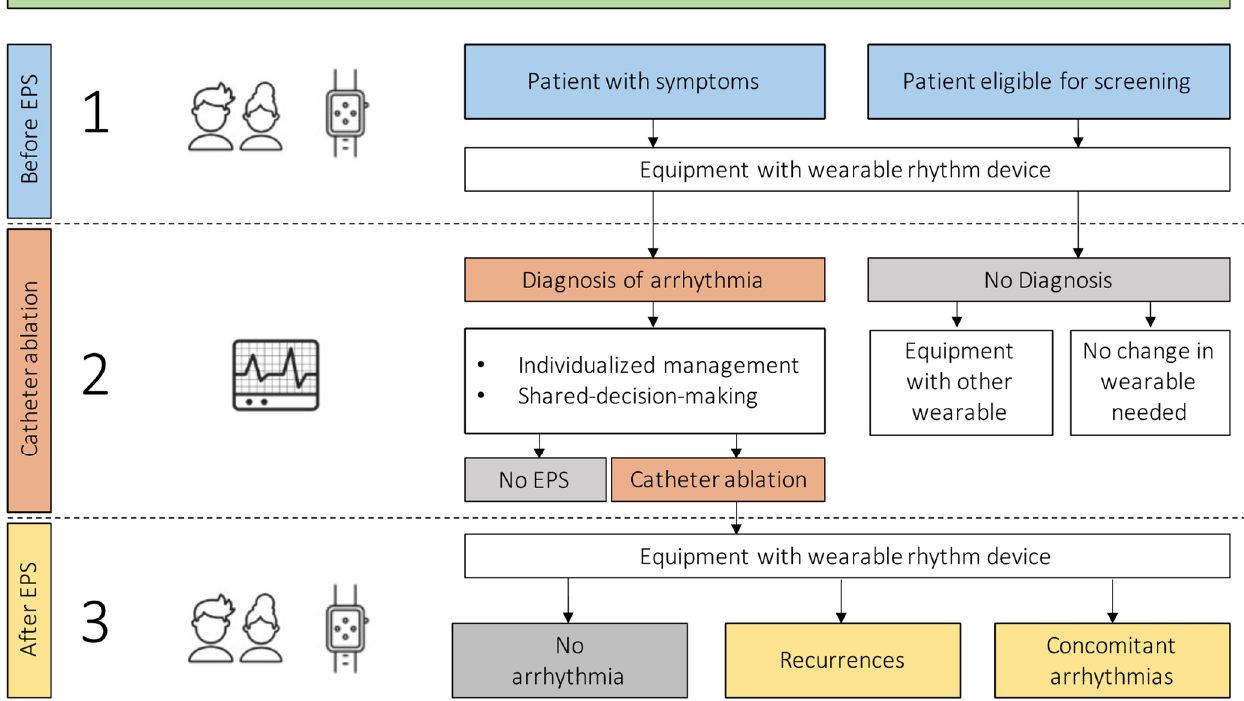
Figure 3. Implementation of wearables for cardiac rhythm monitoring before and after electrophysiological procedures. EPS = electrophysiological study.